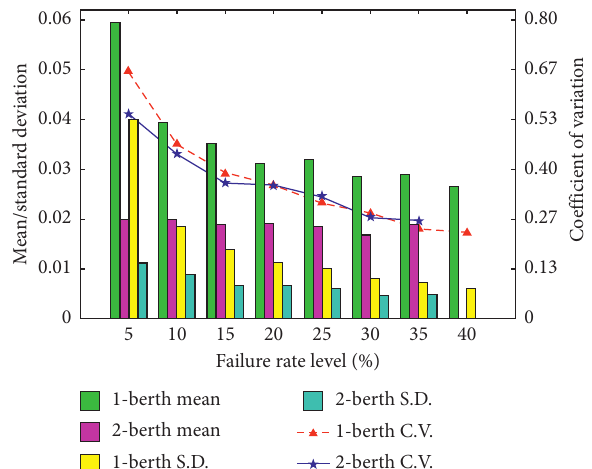
Figure 9: Average mean, S.D., and C.V. of FDR per failure for two types of bus